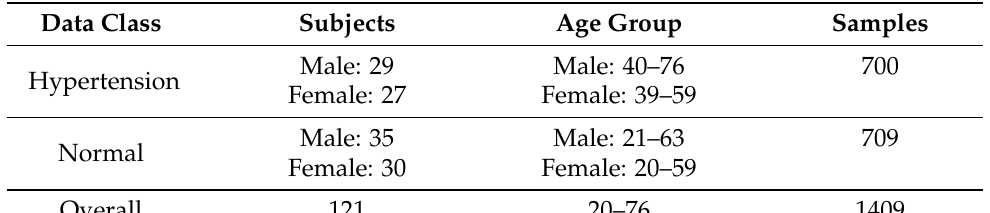
Table 3. Summary of the self-collected PuPG data set.